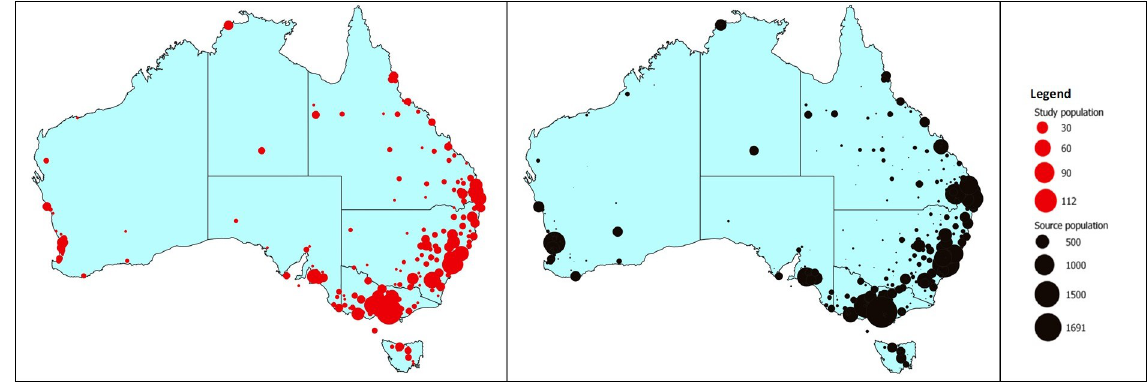
Fig 2. Map of Australia showing the postcode location of the study (•) population and the source (•) population for Australian Thoroughbred racing and training in the 2017–2018 racing season. Each point has been scaled by the number of horses at each location.